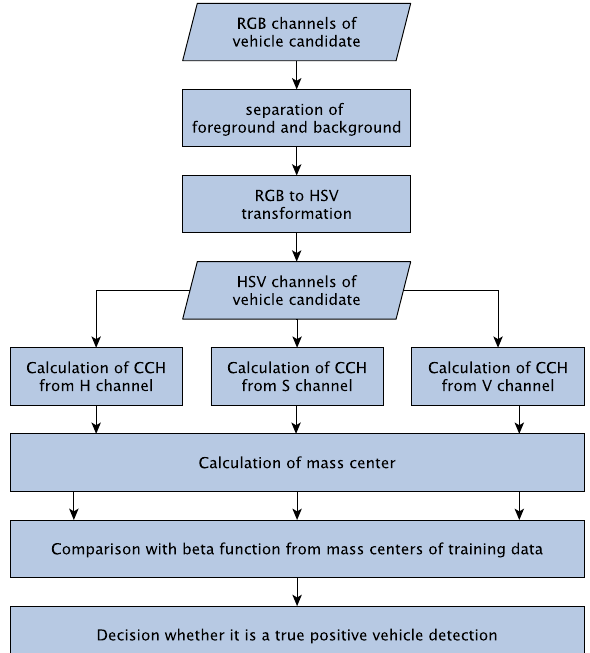
Figure 1: Workflow of the determination of areas where vehicles likely occur. The scheme is for one patch of the image only, all other patches are examined using a sliding window approach.